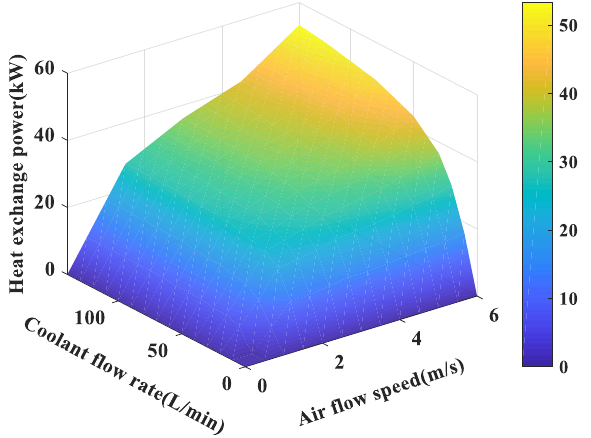
Figure 8. Heat exchange power of radiator at different coolant flow rates and air flow rates.